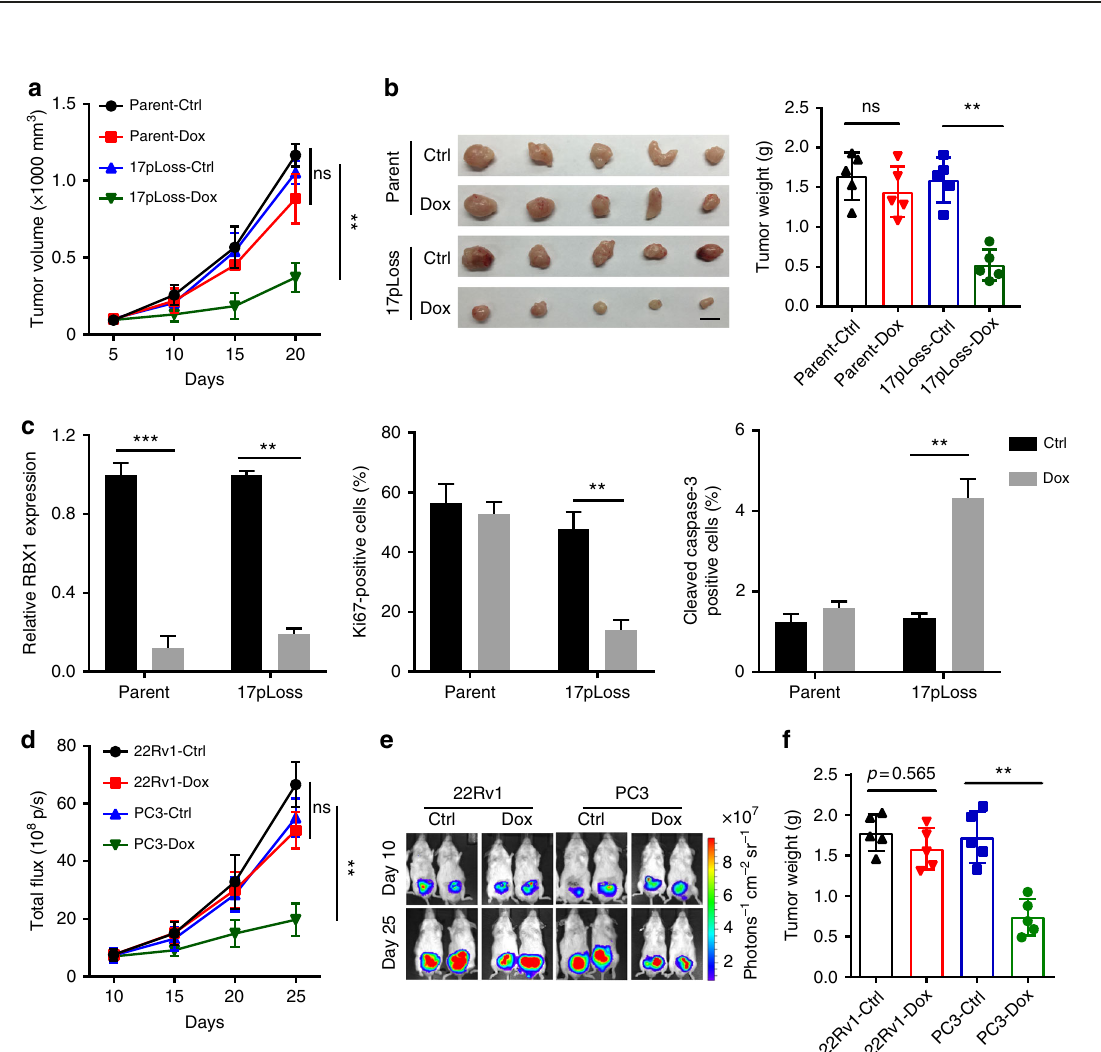
Fig. 3 Prostate cancer cells with 17p deletion are highly sensitive to RBX1 depletion. a , b Effect of RBX1 knockdown on the proliferation of the parental and isogenic 17p loss DU145 cells, determined by direct competition assay. Cells expressing RFP and control nonspeci fi c shRNA (shNT) or shRBX1 were sorted and mixed with control RFP-negative cells (1:1) and the RFP-positive cells were quanti fi ed at passages 2, 4, and 6 ( a ). Representative cell survival measured by staining with crystal violet was shown in b . c – e Cell growth curves, based on crystal violet staining, of human prostate cancer cell lines expressing Dox- inducible shNT or RBX1-speci fi c shRNA (shRBX1 #1, shRBX1 #2) ( c ). RBX1 knockdown ef fi ciency and representative image were shown in d and e , respectively. f Fraction of apoptotic cells in the 17p neutral (22Rv1 and DU145) and 17p loss (PC3 and VCaP) cells expressing Dox-induced RBX1 shRNA at 4 days post Dox treatment. g , h Cell survival measured by crystal violet staining ( g ) and protein expression levels ( h ) of RBX1 in PC3 and VCaP cells expressing shRBX1, control or ectopic RBX1. Data are representative of three independent experiments and analyze by unpaired two-tailed t -test. Error bars denote SD. **, p < 0.01; ***, p < 0.001